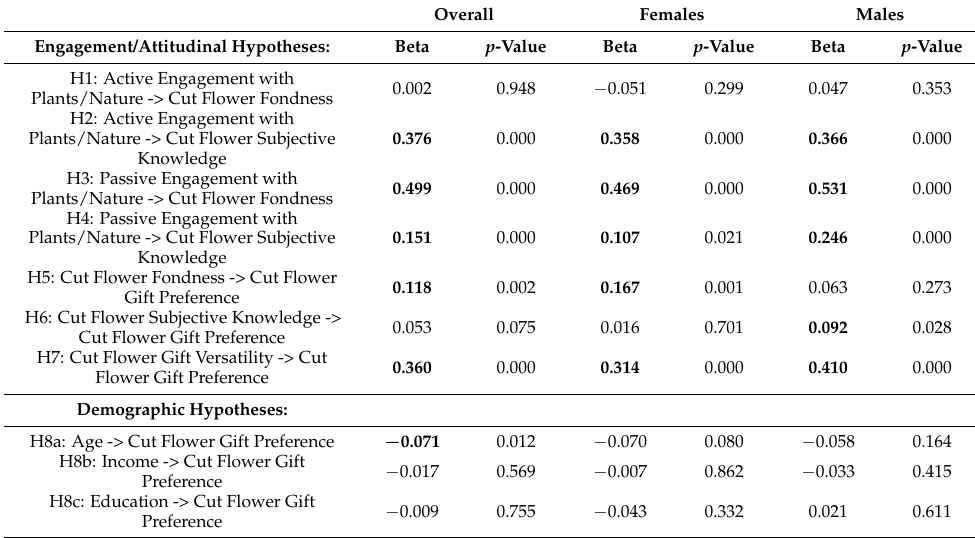
Table 4. Path Coefficient